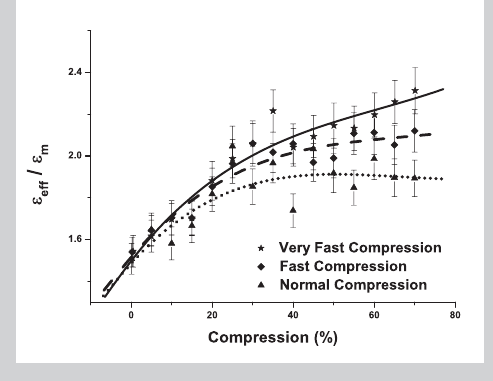
Figure 11: Bottom (a, b) and side (c) views of the particle mono- layers for the very fast com- pression (left, 1.) and the normal compression (right, 2.), after a compres- sion by 60 % (a), 50 % (b, c) of the initial size. Figure 12: Computed effective dielec- tric constant of the nano- particle monolayer, with irreversible bonds, at differ- ent stages of compression for different compression rates: 10 -4 ( ¯ , ——), 5·10 -5 ( Ï , ----) and 10 -5 ( Ú , • • • •) per simulation unit time. The black lines represent the best polynomial fitting of order 3, for each